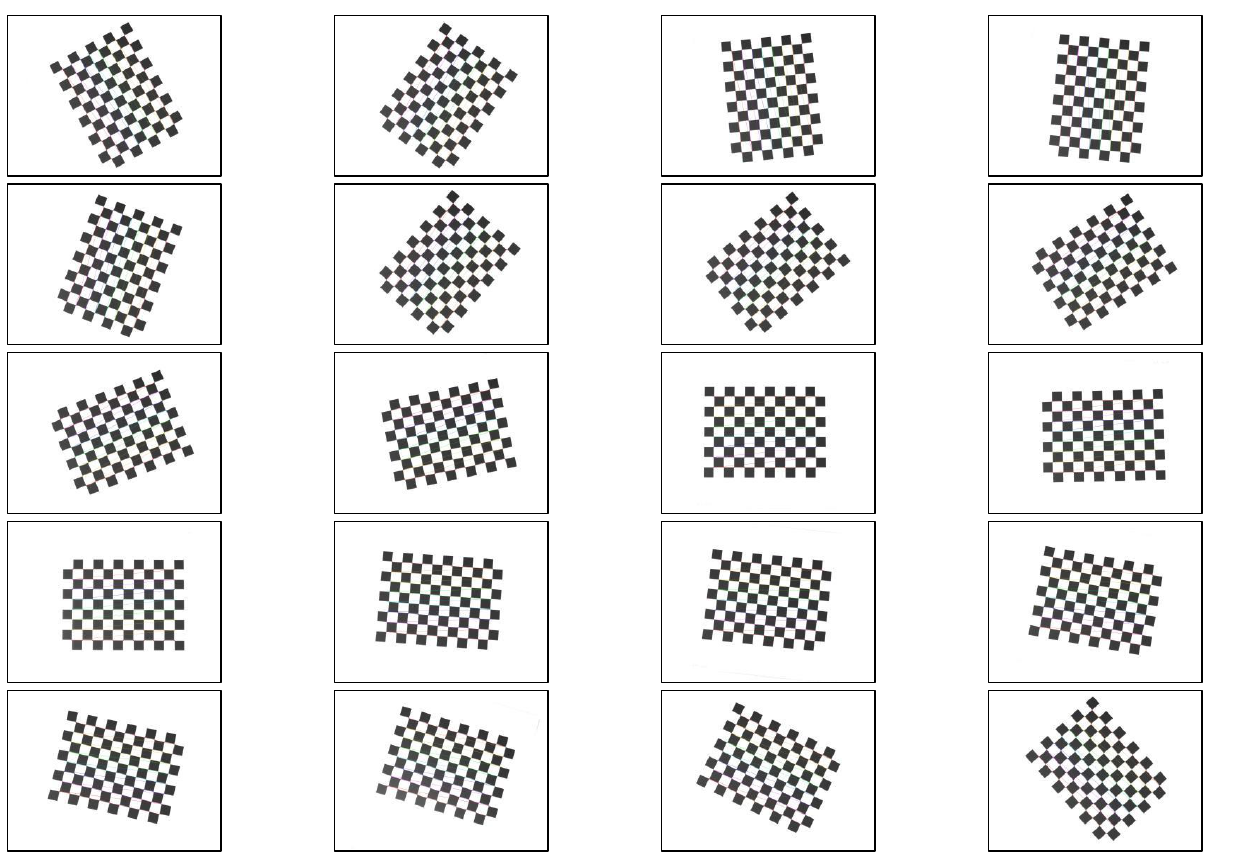
Figure 3. Different angle checkerboard grid calibration diagram.